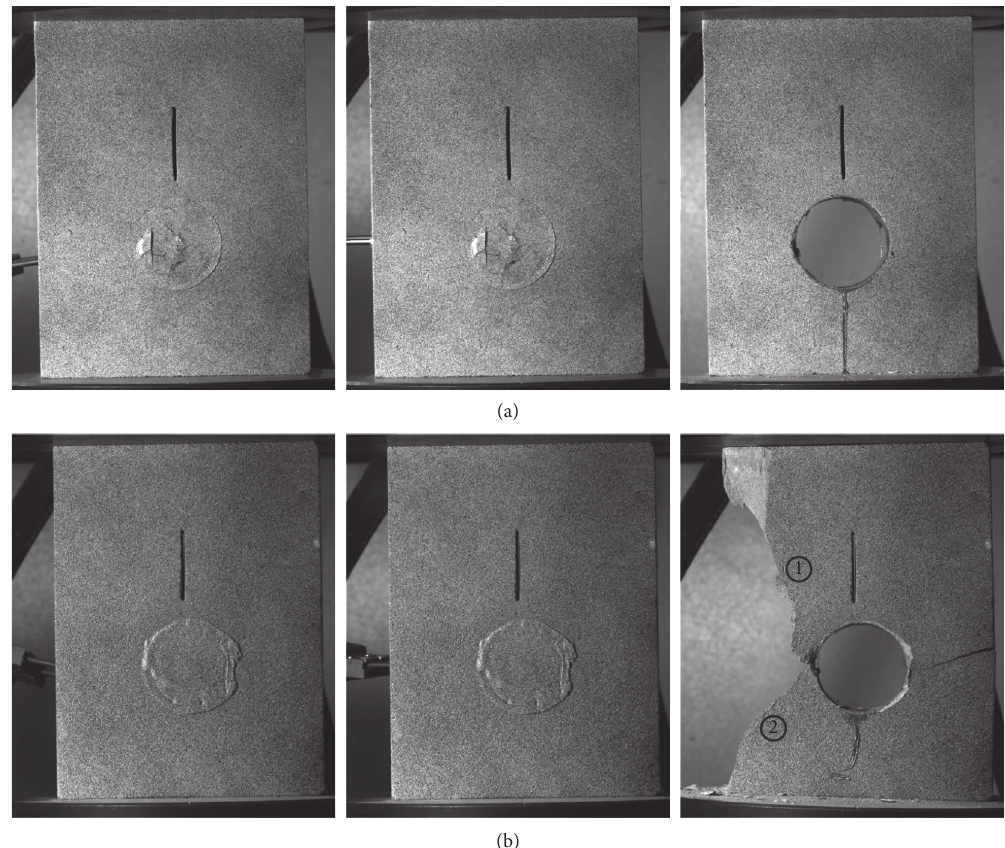
Figure 8: Crack evolution process of α � 90 ° : (a) S-90-80; (b) S-90-100.